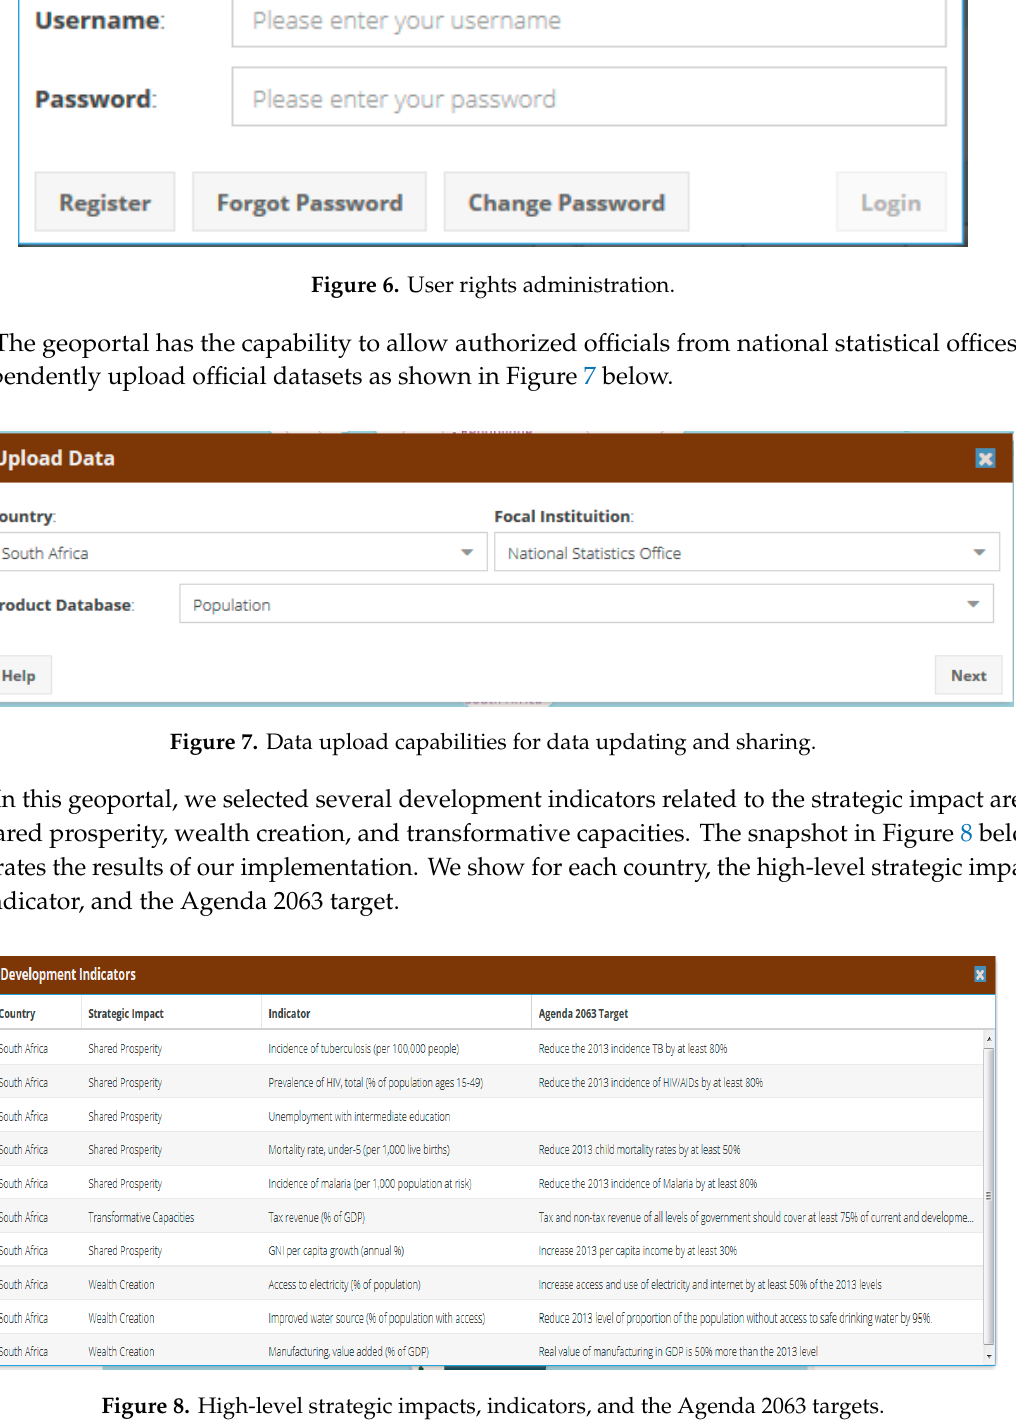
Figure 9. Charting options are provided by the front end for visual analysis.